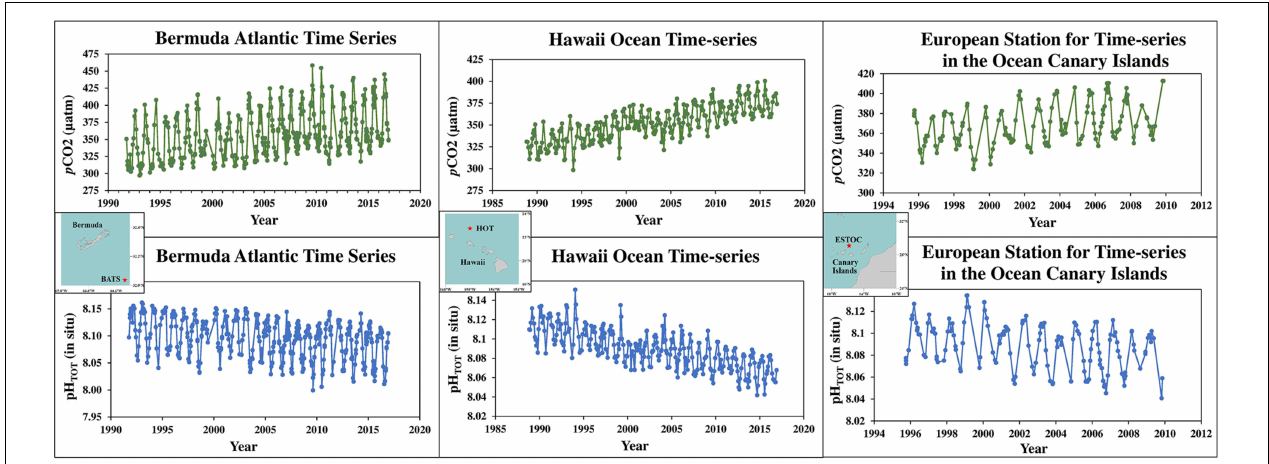
FIGURE 3 | Time series of in situ pCO 2 (top) and pH T (bottom) for three time series stations in the Atlantic and Pacific Oceans. Data sources: BATS data: http://batsftp.bios.edu/BATS/bottle/; Hot data: University of Hawaii (http://hahana.soest.hawaii.edu/hot/products/HOT_surface_CO2; ESTOC data: